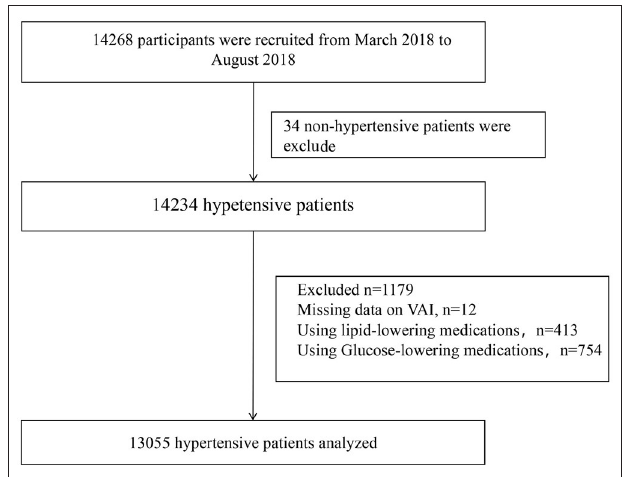
FIGURE 1 | Flow chart of study